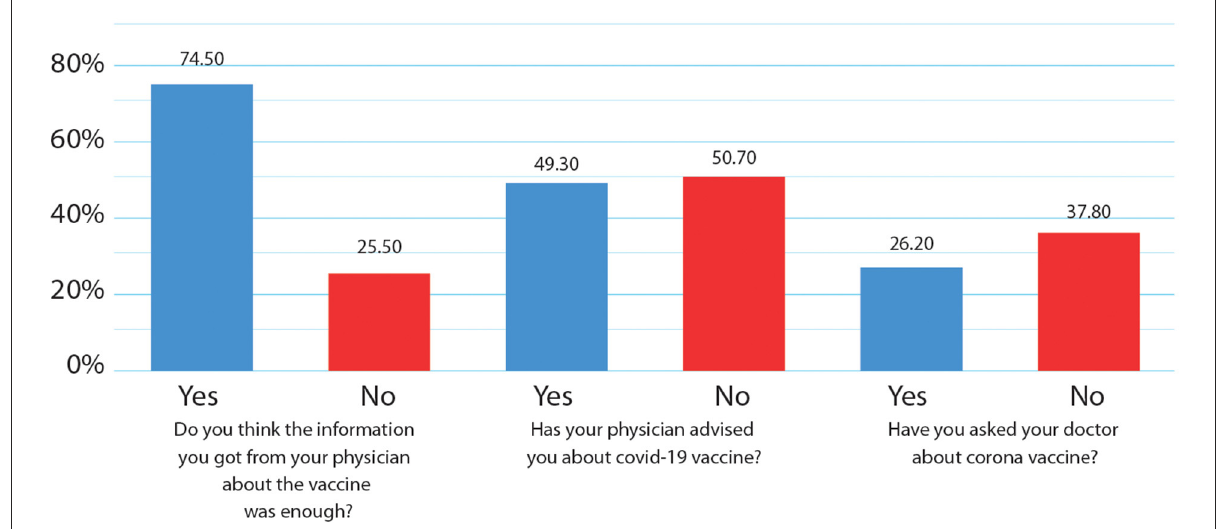
FIGURE4 Current physician practices concerning counseling on SARS-CoV-2